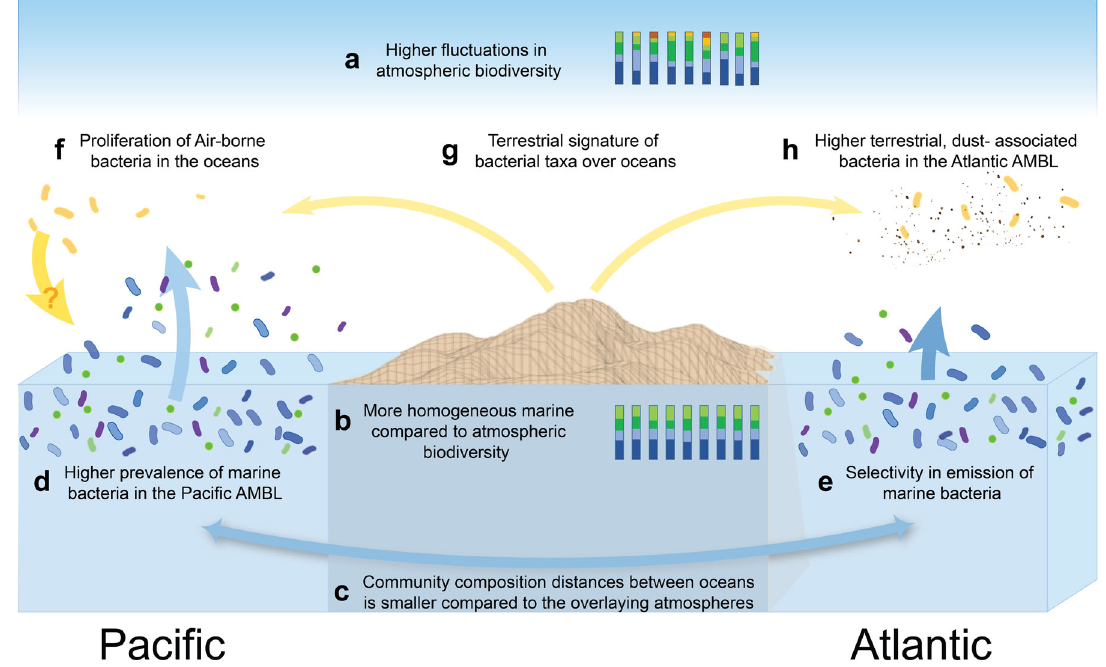
Fig. 4 A conceptual model presenting the main fi ndings of this study. Higher distances between microbial composition in air samples is probably induced by residence time rather than by physical mixing ( a , b ). The microbial compositions of similar environments (e.g., Atlantic and Paci fi c Oceans) are more similar than geographical relations (e.g., Paci fi c atmosphere and surface water; c ). The marine bacterial aerosolization seems to be selective ( d ) and differs in ef fi ciency for different oceans ( e ). The atmospheric contribution to the marine ecosystem was not detected in the framework of this study ( f ), but it cannot be excluded that differences in atmospheric microbial composition could impact deposition and surface water composition and function. A terrestrial signature was detected in a remote oceanic environment ( g ), with a signi fi cant contribution of terrestrial- and dust-associated bacteria in the Atlantic atmospheric marine boundary layer compared to the Paci fi c ( h